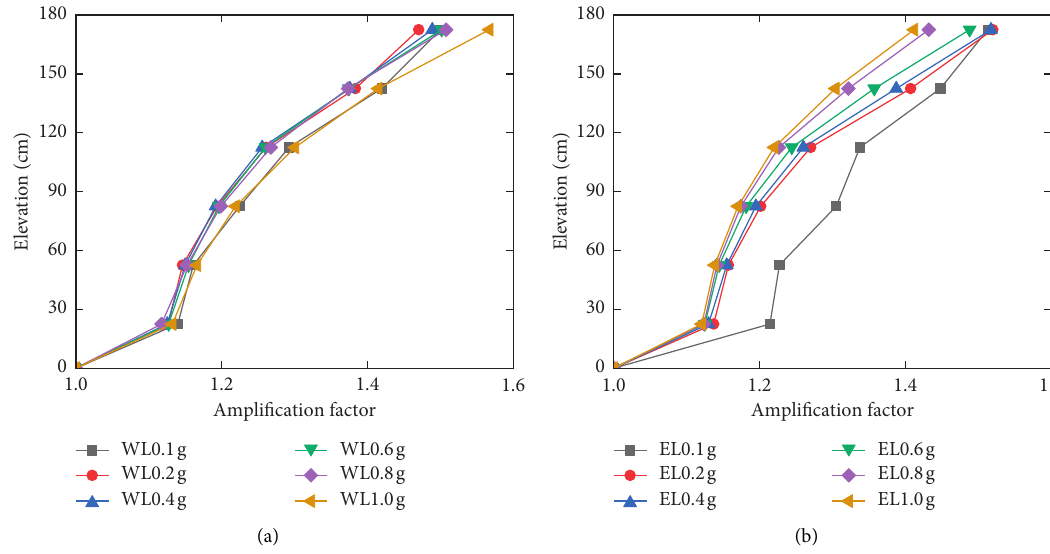
Figure 9: RMS amplification factor for the reinforced zone (scale factor: 1/2): (a) WL and (b)